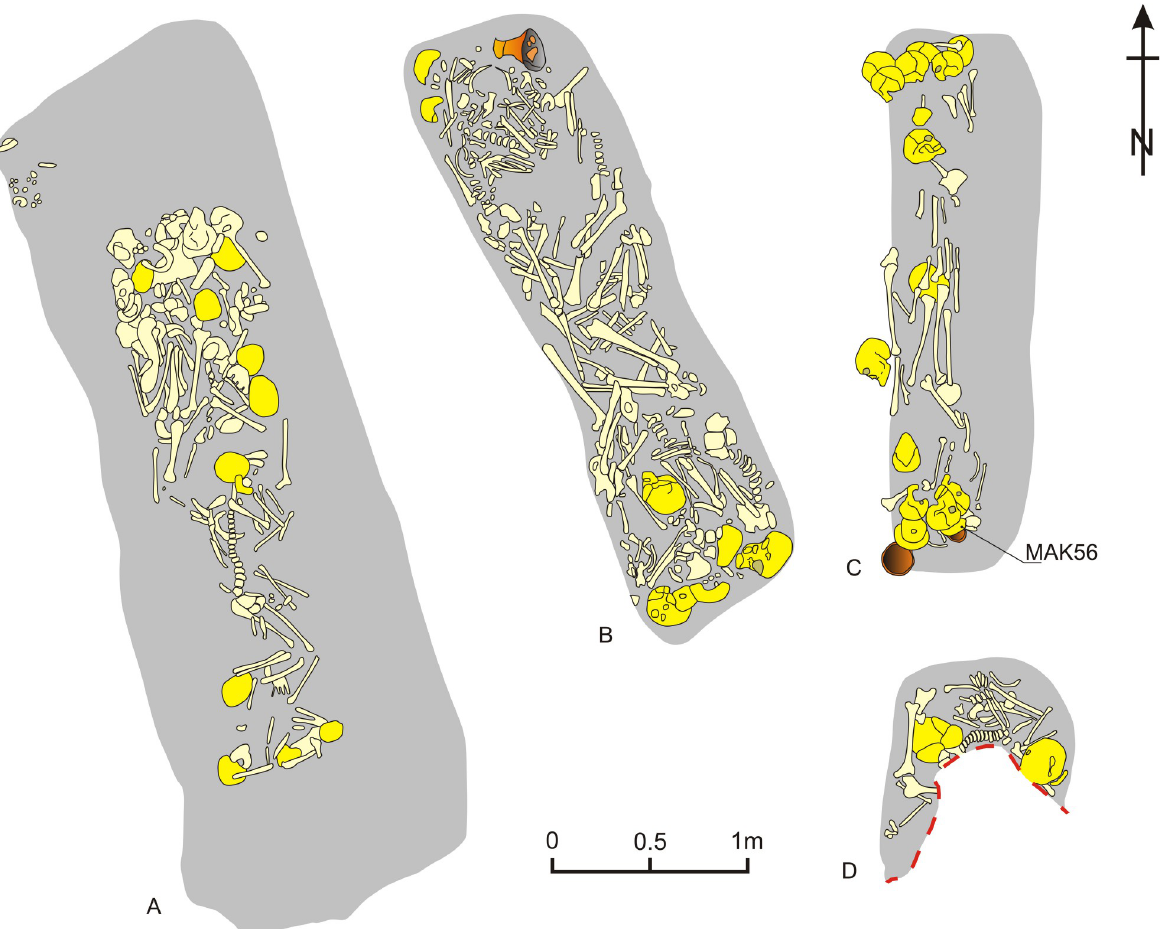
Fig 2. Simplified outlines of graves nos. 69 (A) and 99 (B) in Ż erniki Go´rne (after [51]) and nos. 4 (C) and 5 (D) in Gustorzyn (after [48], simplified). Human and animal bones are marked in yellow. In Gustorzyn darker shade marks bones described by excavators as belonging to human skulls, in Ż erniki Go´rne human skulls were solely recognised basing on published figures; stone constructions were omitted.